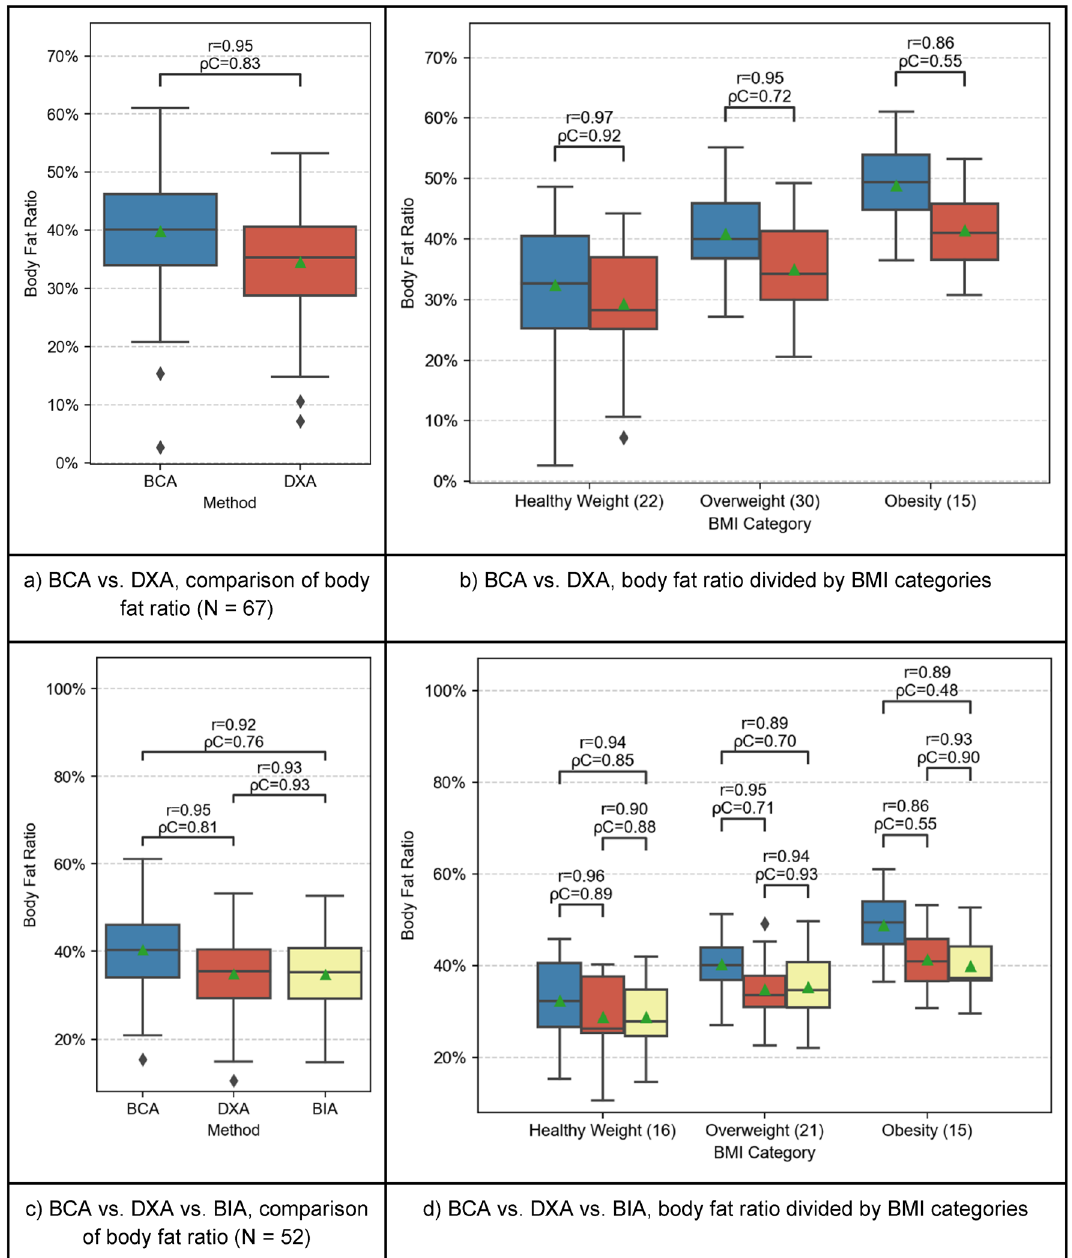
Figure 2. Comparison of BFR between BCA (blue), DXA (red) and BIA (yellow). In the plots ( a , b ), BCA and DXA are compared separately because more patients received PET/CT- and DXA scans. Patients with all three measurements available are compared in plots ( c , d ). The boxplots represent the distribution of the patient’s BC measurements. The mean is indicated with a green triangle and the outliers are indicated with a rhombus. The samples are compared using Pearson’s r correlation coefficient (r) and Lin’s concordance correlation coefficient FFM were highly correlated (r = 0.96, r = 0.91, and r = 0.95). Furthermore, the Bland–Altman analysis comparing the difference (DXA–BIA) versus average of DXA and BIA results showed a general agreement between the two methods (Supplementary Fig. 1). It was concluded that BIA may provide valid measures of FM, percentage of FM, and FFM, and could be used as a practical tool for the assessment of body composition in diabetics. In addition, Fürstenberg and Davenport et al. 11 analyzed BIA and DXA for the assessment of whole-body and segmental body composition in hemodialysis patients. Comparing the difference versus the average of DXA and BIA, it was found that the whole-body FM and LM (lean mass) measured by the two methods were highly correlated (r = 0.92 and r = 0.93 in Bland–Altman analysis). The results of previous studies are in agreement with our results, therefore indicating that the methods are interchangeable.